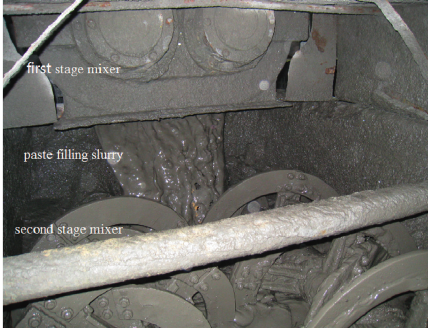
Figure 5: Preparation of paste filling